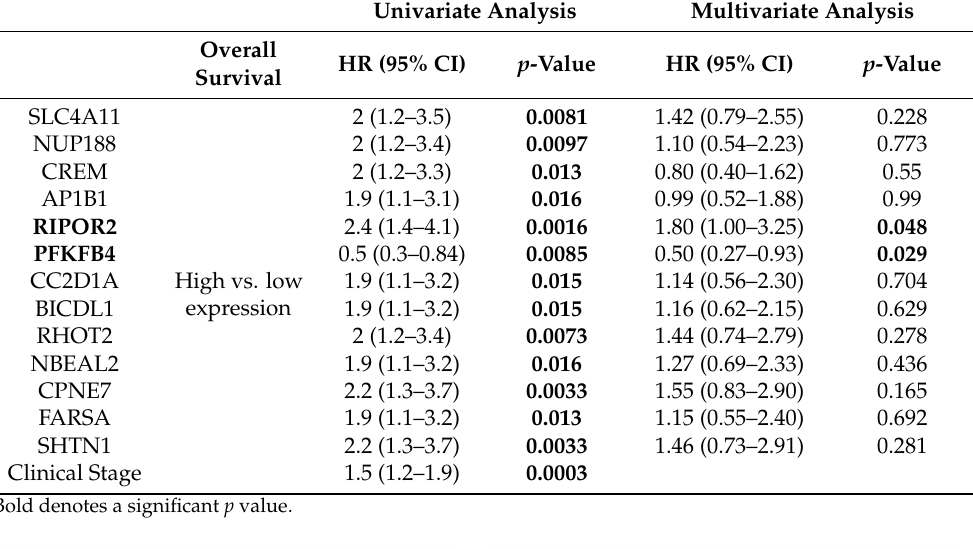
Table 1. Univariate and multivariate analyses of the genes affecting the overall survival.